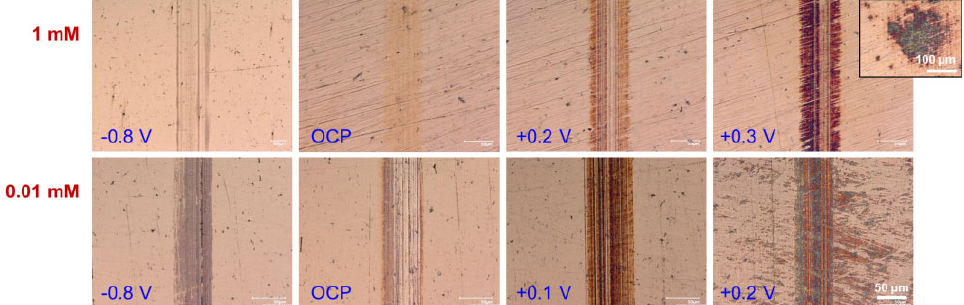
Fig. 5 Surface morphologies of the wear tracks on Cu plate with different SDS aqueous solutions (1 or 0.01 mM) as lubrication under different applied surface potentials (the insert shows the morphologies near the track on the Cu plate at +0.3 V in 1 mM SDS solution after the friction test of 100